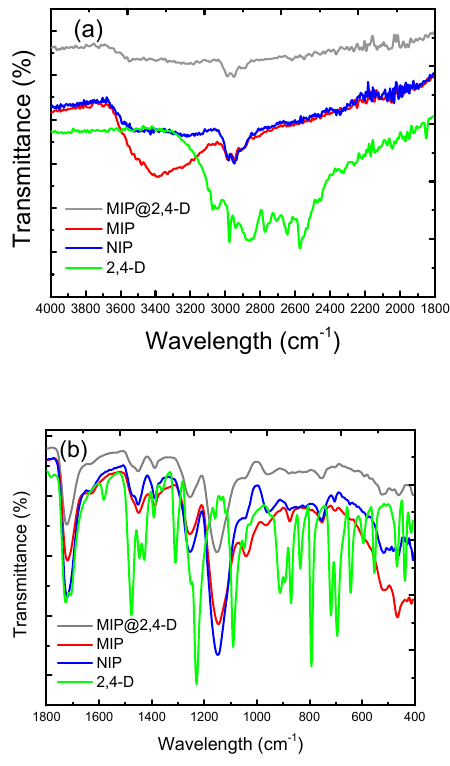
Figure 4. IR spectrum showing the bonding structure of molecularly imprinted polymers (MIP@2,4-D) before removal of the 2,4-D, MIP after the removal of the 2,4-D by washing, non-imprinted polymers (NIP), and the 2,4-D template analyte: ( a ) IR spectrum from 4000 to 2000 cm − 1 ; and ( b ) IR spectrum from 2000 to 400 cm − 1 .